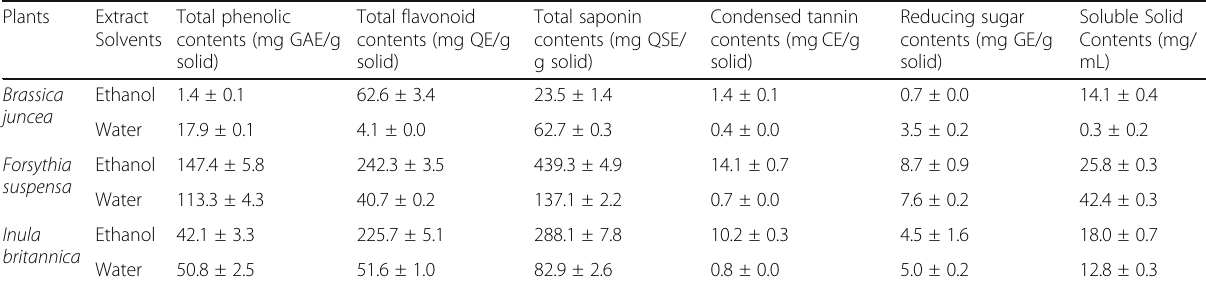
Table 1 Phytochemical screening of Brassica juncea , Forsythia suspensa, and Inula britannica extracts